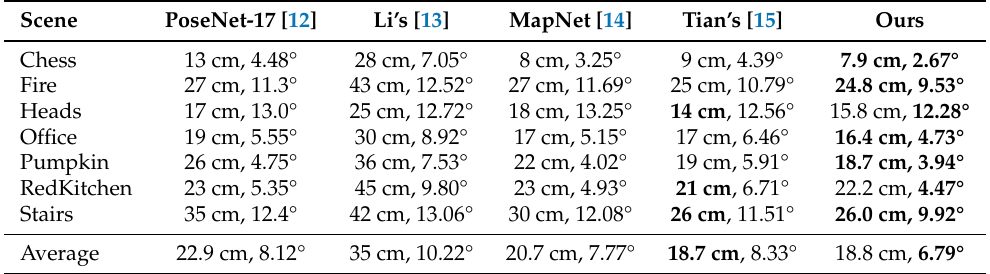
Table 3. Median translation error (cm) and rotation error (°) for various APR methods on 7 Scenes . Bold numbers indicate the lowest error value.